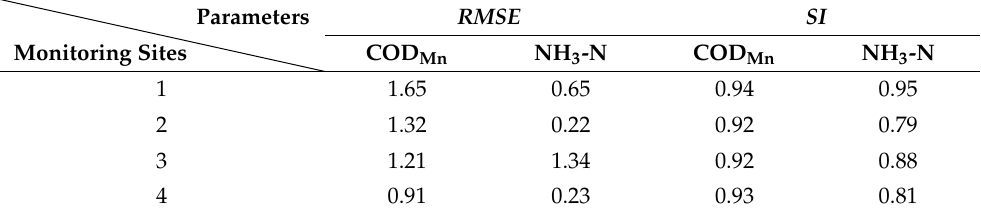
Table 2. Simulation results of water quality monitoring